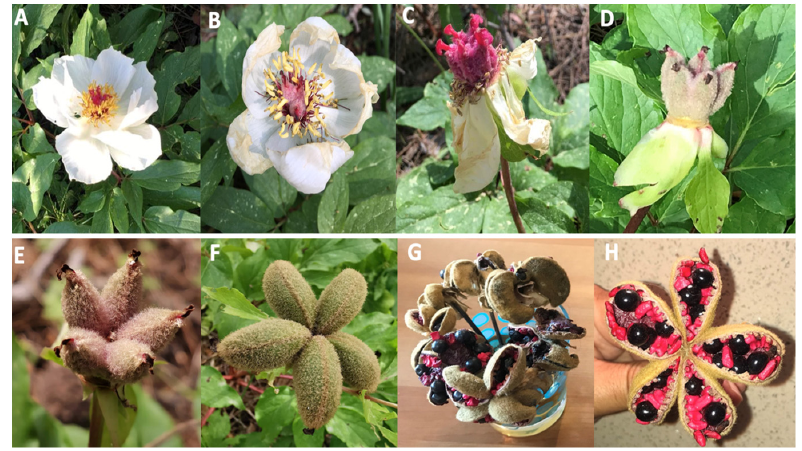
Figure 1. The cycle of flowers ( A – G ) to full seed maturation ( H ). Photographs from V. Kasapis, April 2019.